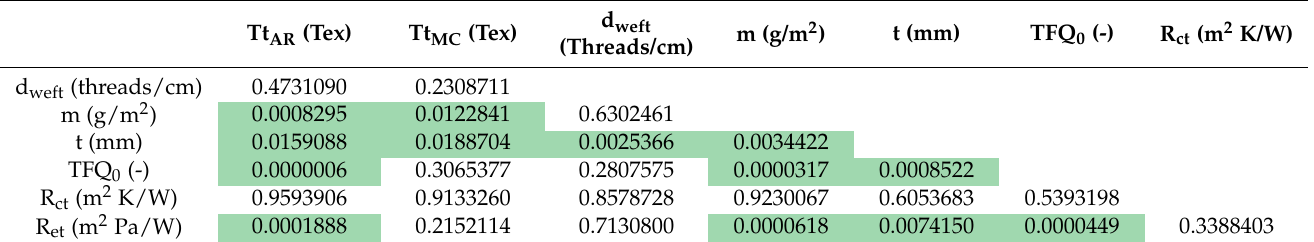
Table 7. p -values of correlated